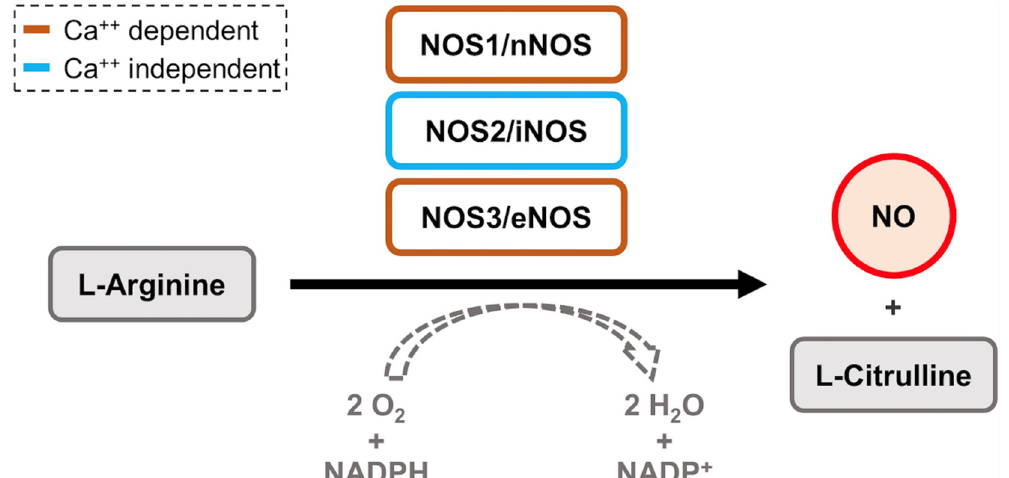
Figure 1. NOS enzymatic reaction. The chemical reaction catabolized by all the three human NOS enzymes involves the formation of L-citrulline and NO from L-arginine and in presence of O 2 and NADPH. The three known human NOS genes are: NOS1 or neuronal NOS (nNOS), NOS2 or inducible NOS (iNOS), and NOS3 or endothelial NOS